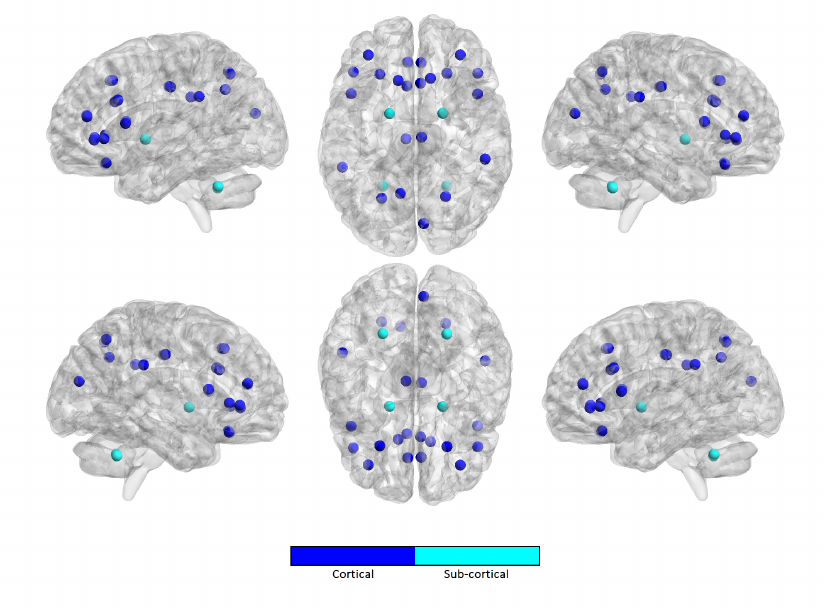
Figure 6. The most significant ROIs for the RF age prediction with age covariate harmonization in NC population.